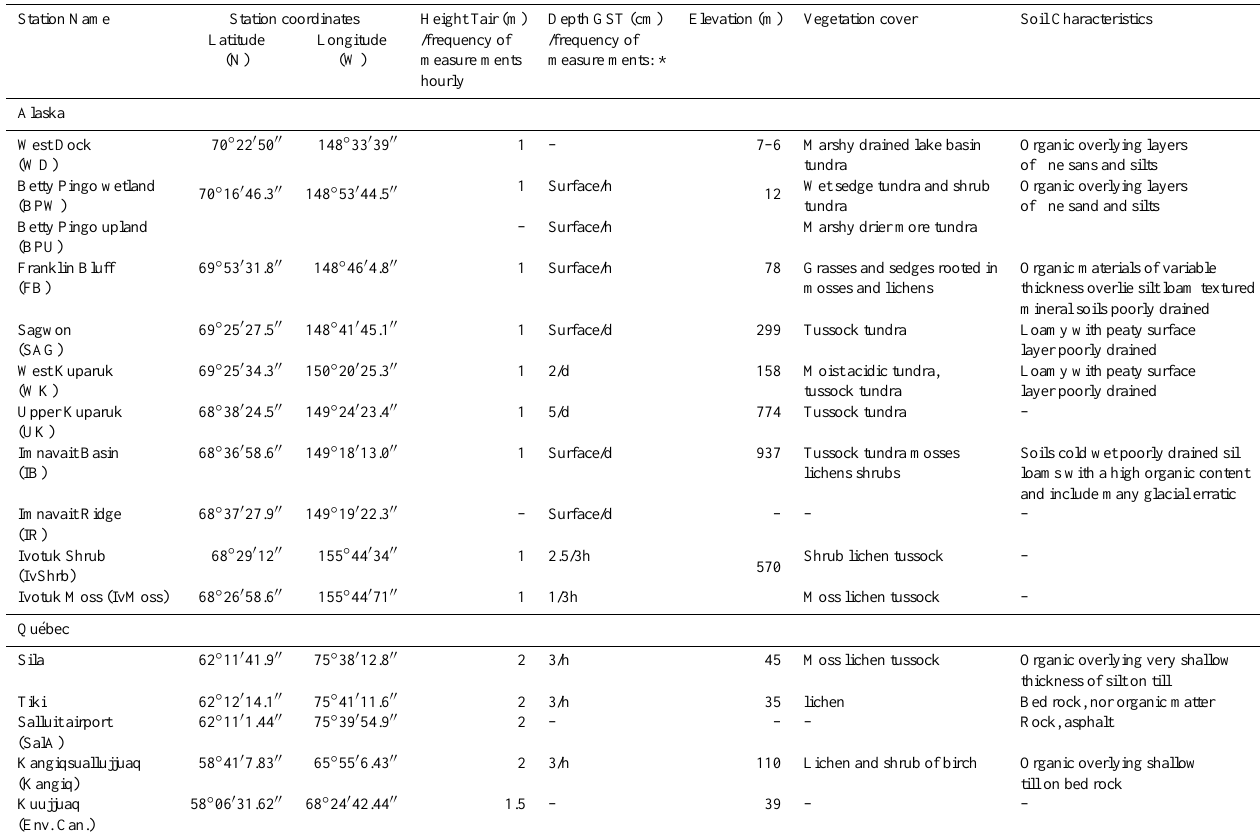
Table 1. Characteristics of the field sites used as reference